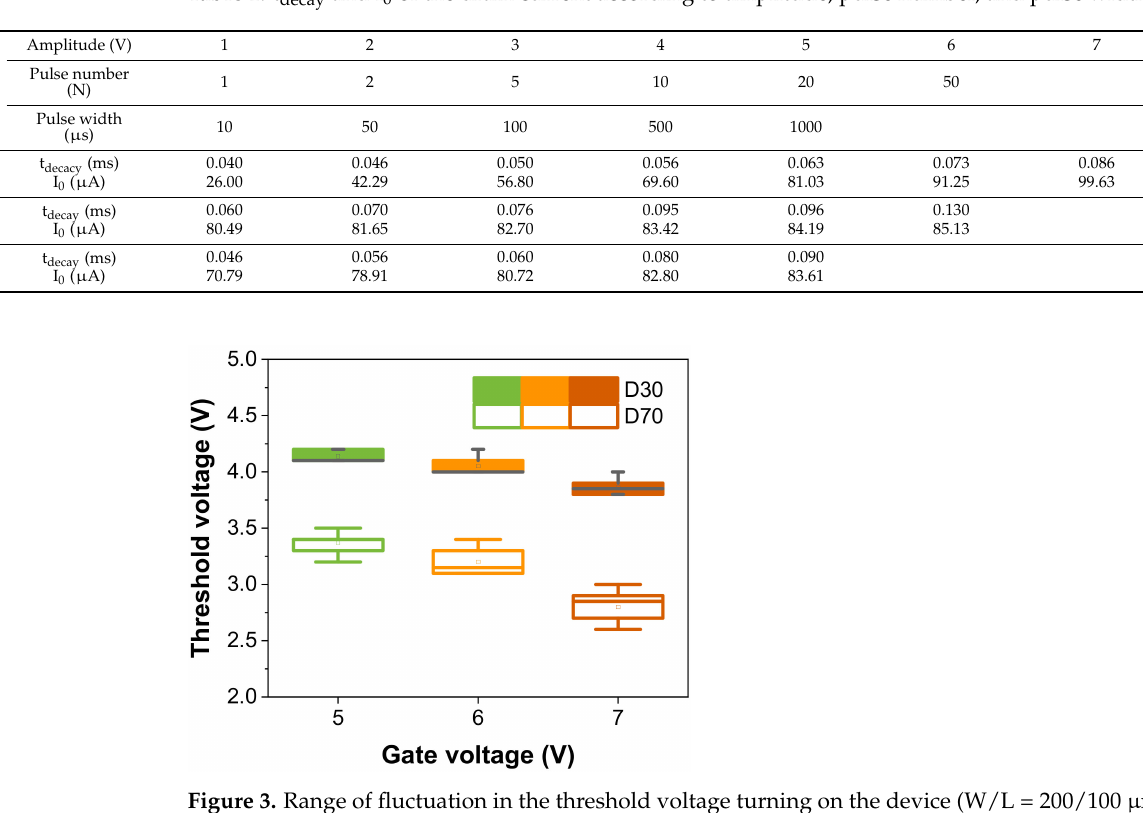
Figure 2. The I d − V g curves of ~30-nm CeO x with HfAlO x layer device. The drain currents from ( a ) cell-to-cell measurements at W/L = 200/200 µ m, ( b ) cycle-to-cycle with W/L = 200/100 µ m, and ( c ) cell-to-cell with W/L = 400/100 µ m at V d = 0.1 V. The green, yellow, and brown lines indicate applied V g in sweeping up to: 5 V, 6 V, and 7 V, respectively. The red arrows at the top indicate the changes in length and width between the measured devices in ( a , c ) in reference to the device in ( b ). Table 1. t decay and I 0 of the drain current according to amplitude, pulse number, and pulse width.